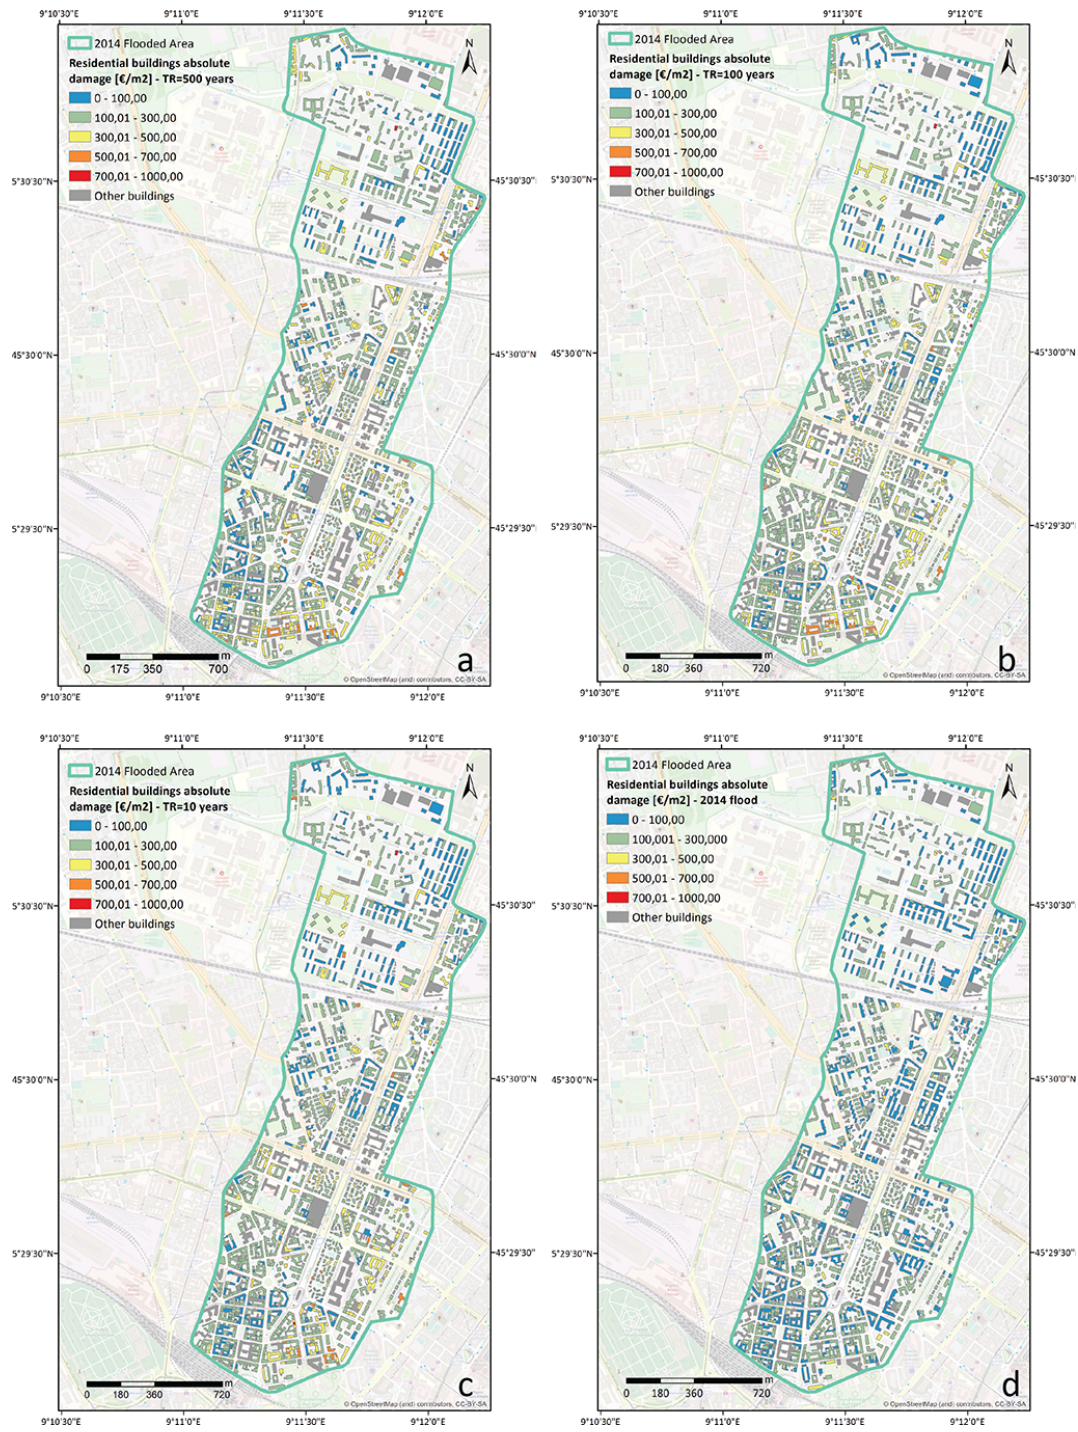
Figure 13. Microscale absolute damage mapping considering return period scenarios of (a) 500, (b) 100 and (c) 10 years and (d) the 2014 flood event for the two most vulnerable building category subsets. Base maps and built-up-area shapefile are from © OpenStreetMap contributors 2022. Distributed under the Open Data Commons Open Database License (ODbL) v1.0.